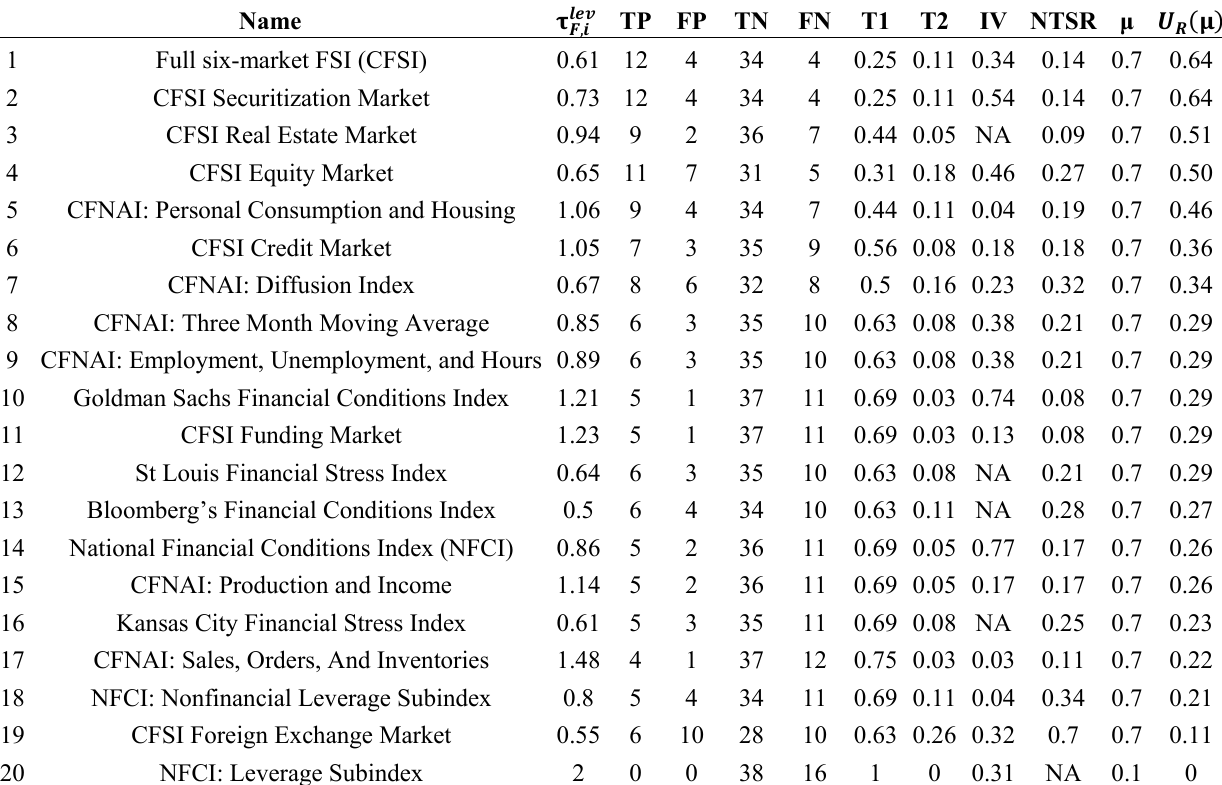
Table 3. Comparison of information quality of alternative financial stress